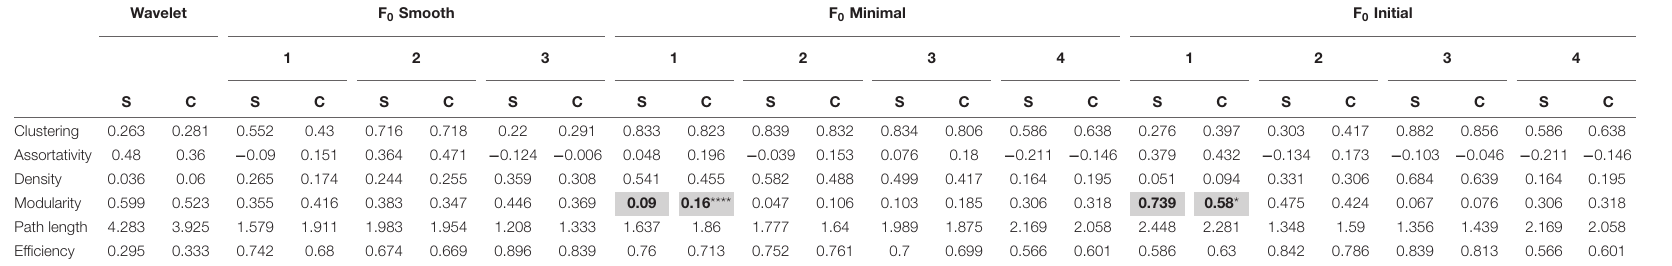
TABLE 3 | Neuron network measures found using each of the tested